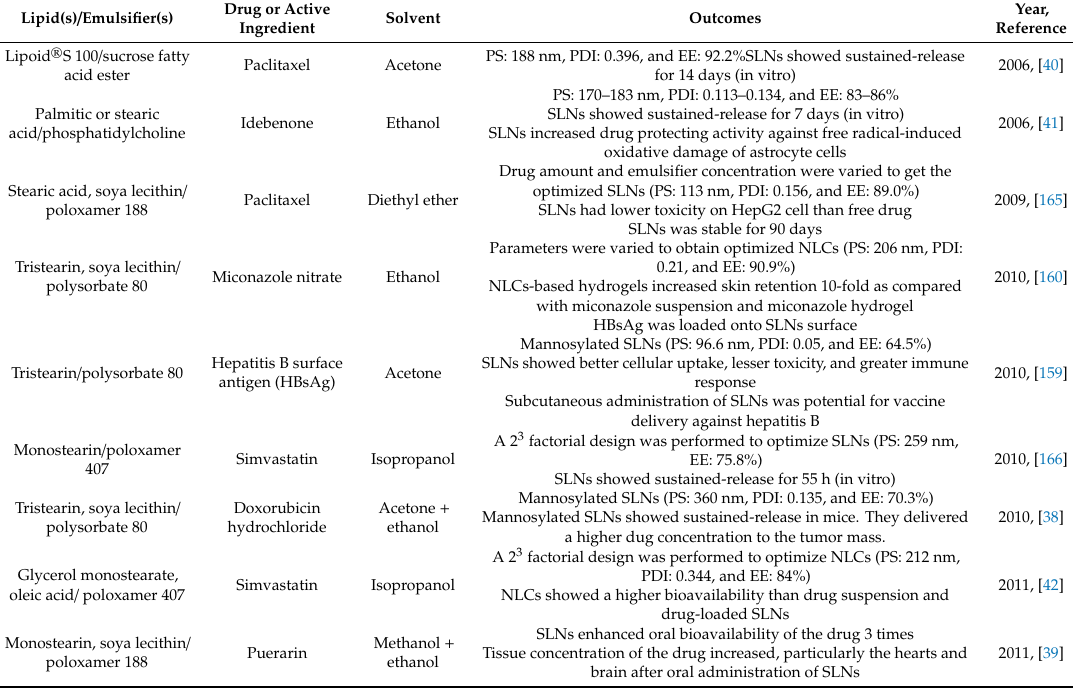
Table 2. Overview of lipids, emulsifiers, drugs, and solvents used to prepare SLNs and NLCs by solvent injection method and their significant